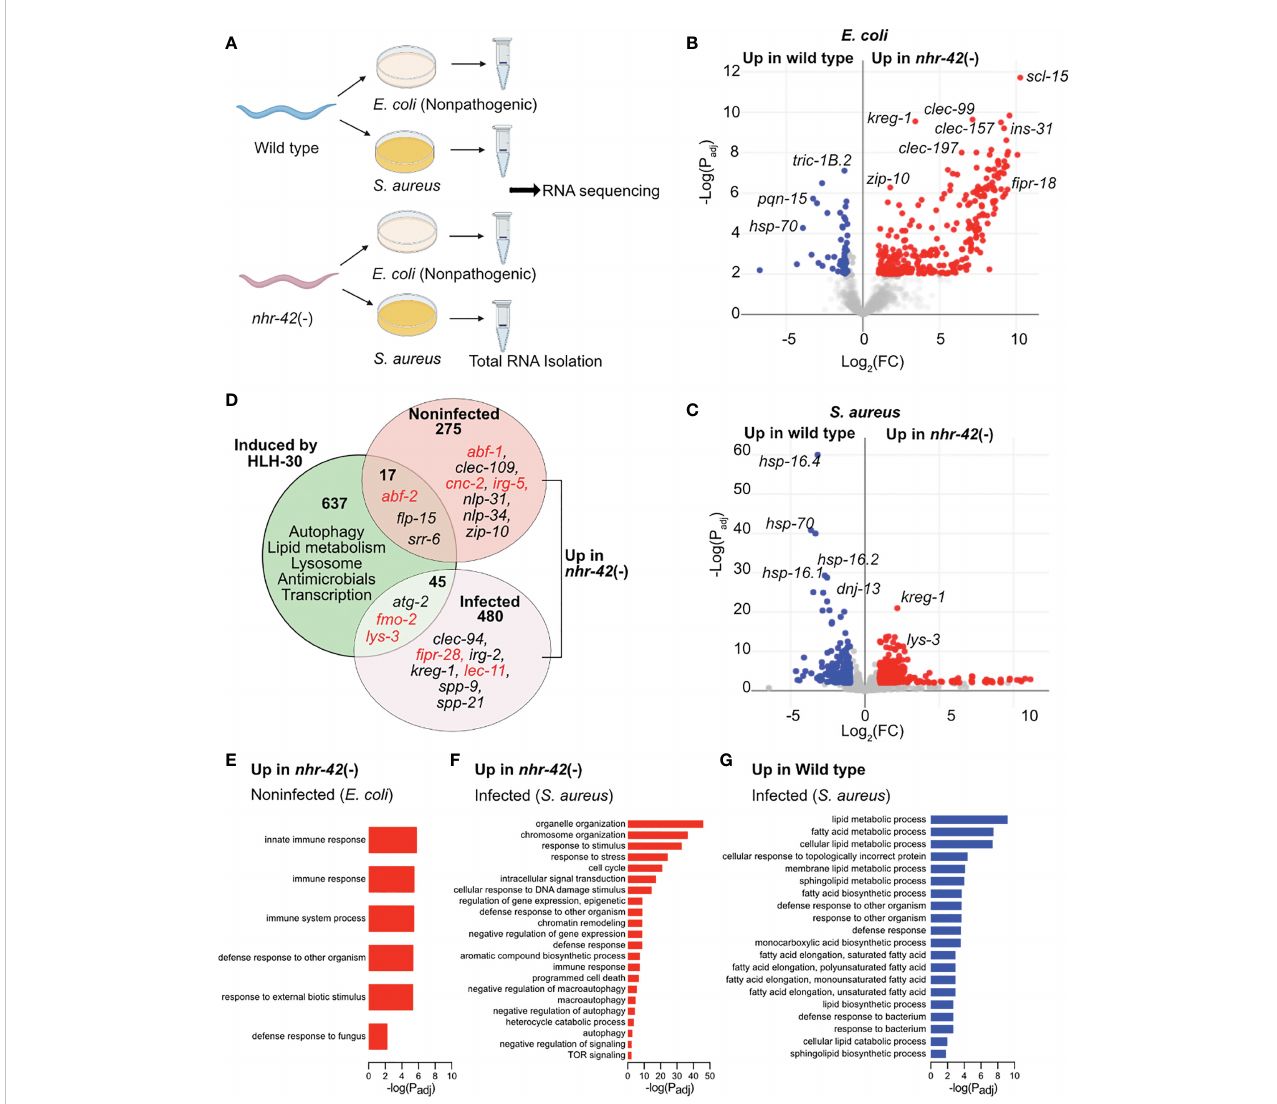
FIGURE 3 nhr-42 regulates host defense and metabolism genes (A) Experimental design for RNA-seq of wild type and nhr-42 (tm1375) animals fed E. coli OP50 or infected with S. aureus SH1000 for 5 h. (B) Representation of differentially expressed genes in noninfected nhr-42 (tm1375) animals compared to wild type. Red, genes upregulated in nhr-42 (tm1375); blue, genes upregulated in wild type. FC, fold change. P adj , adjusted P value. (C) Representation of differentially expressed genes in infected nhr-42 (tm1375) animals compared to wild type. Red, genes upregulated in nhr-42 (tm1375); blue, genes upregulated in wild type. (D) Summary of genes induced by HLH-30 during S. aureus infection (8) and genes that are upregulated in noninfected and infected nhr-42 (tm1375) animals. Numbers indicate total number of differentially expressed genes in each sector. Speci fi c examples of antimicrobial genes are provided in each sector, and relevant genes are highlighted in red. (E) GO over-representation among upregulated genes in noninfected nhr- 42 (tm1375) animals relative to wild type. (F) GO over-representation among upregulated genes in infected nhr-42 (tm1375) animals relative to wild type. (G) GO over-representation among upregulated genes in infected wild type animals relative to nhr-42